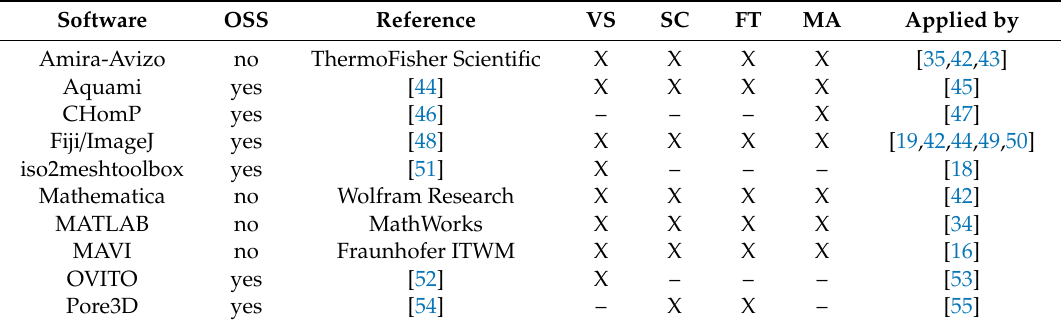
Table 1. Software packages applied for the characterization of nanoporous metals. Application types are indicated as 3D volume / interfacial surface (VS), skeleton centerline (SC), feature thickness (FT), and morphological analysis and descriptors (MA). Right column: Selected papers where the software packages have been